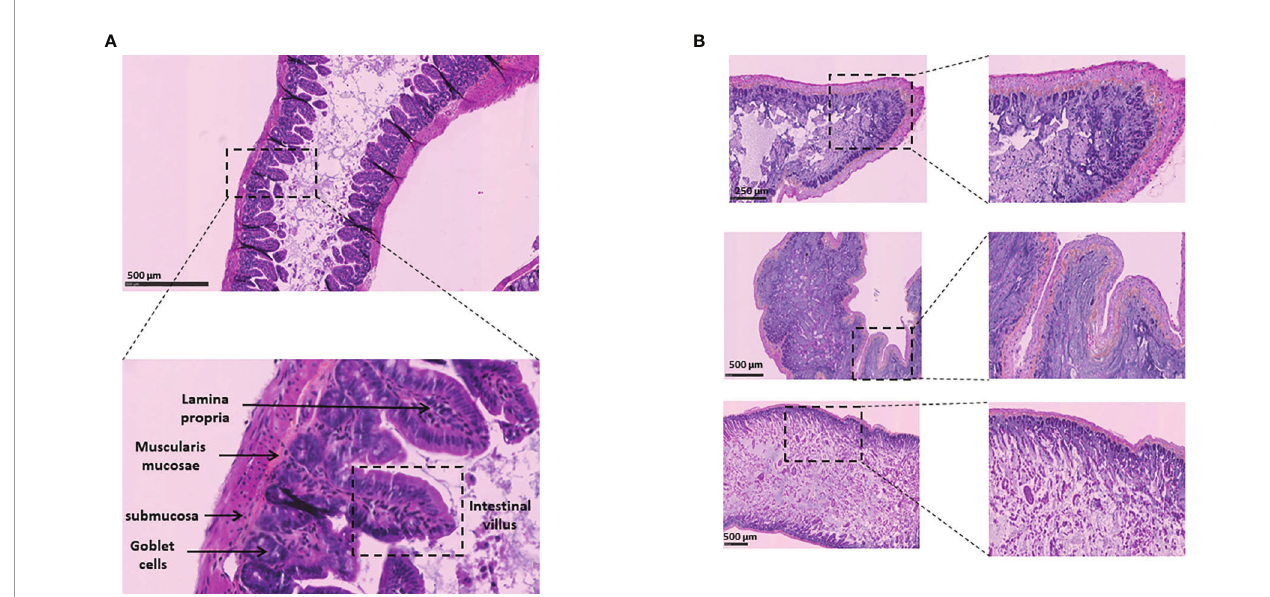
FIGURE 11 | Histological analysis of intestinal tissues from K18-hACE2 transgenic mice (virus free) and K18-hACE2 transgenic mice infected via intranasal administration of SARS-CoV-2. (A) Normal intestinal wall from control K18-hACE2 transgenic mouse (hematoxylin-phloxin-saffron staining). (B) Section of intestine from K18-hACE2 transgenic mouse infected with SARS-CoV-2. The upper, middle and lower panels correspond to samples from 3 different mice. Note the extensive necrosis and in fl ammation of the lamina propria of intestinal villi with degeneration of intestinal epithelial cells in the intestinal